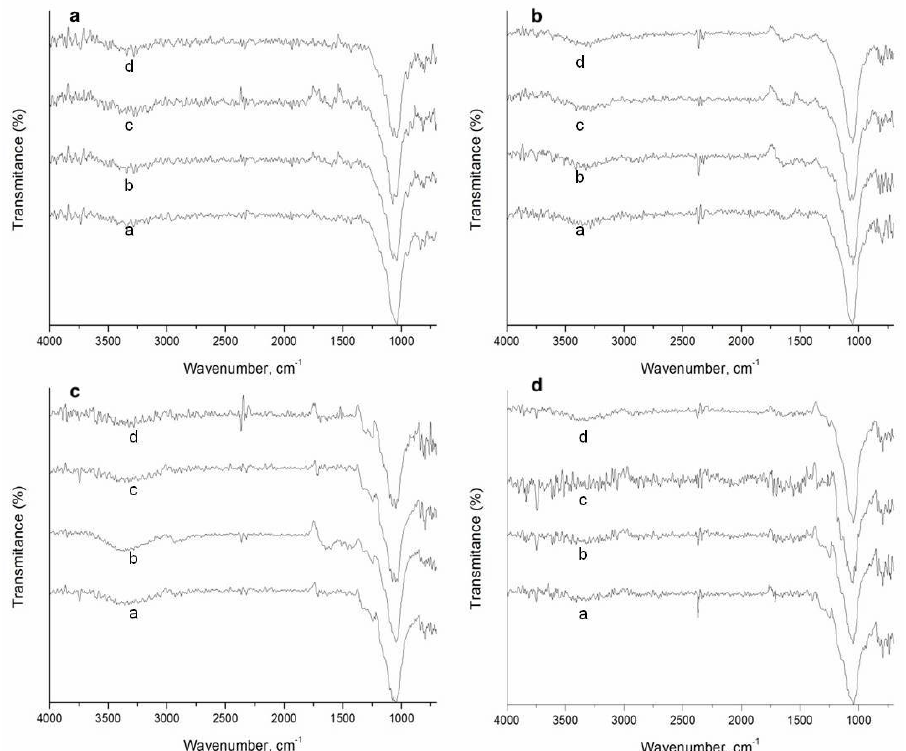
Figure 6. FTIR spectra of rice hull